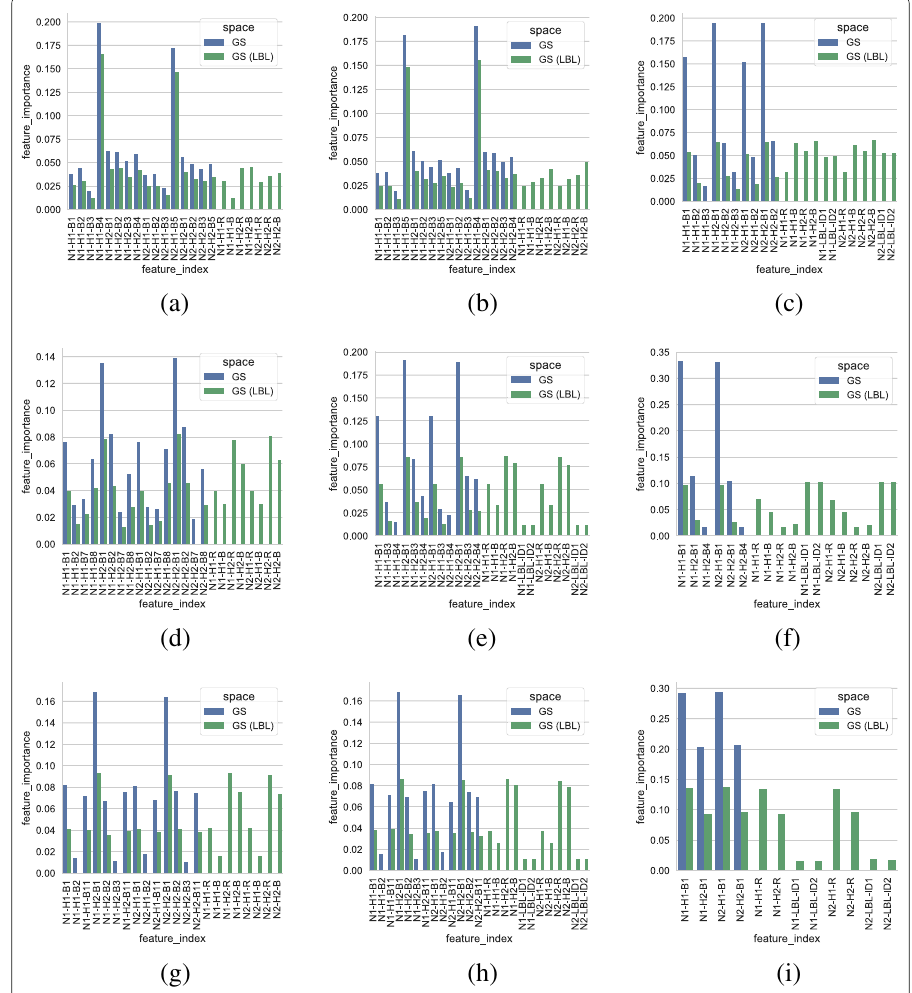
Fig. 6 Probability distribution of the feature importance scores across original networks. NDD features are presented in the index order of node (N), hop (H) and bin (B). As an example, the feature N1-H2-B1 presents the first bin of the NDD 2 1 [ k ] vector. NAD features are presented in the index order of node (N), hop (H) and binary attribute value ∈ R , B . As an example, the feature N1-H2-R presents NAD 2 1 [ R ]. Any feature that does not contribute to the final prediction decision with at least 1% of the samples in average is